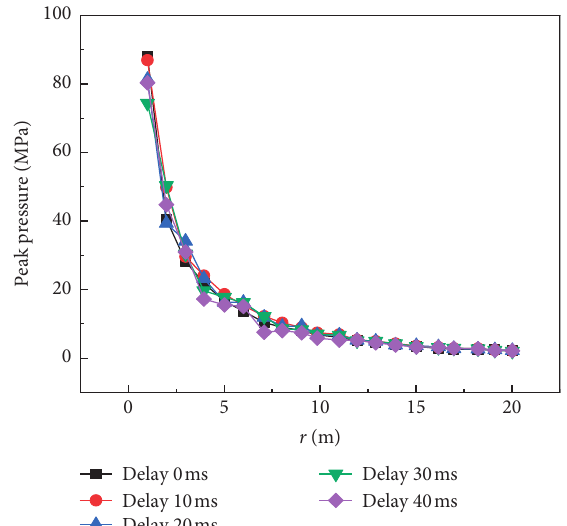
Figure 5: The change of the peak pressure in the direction of the minimum resistance line with the burst center